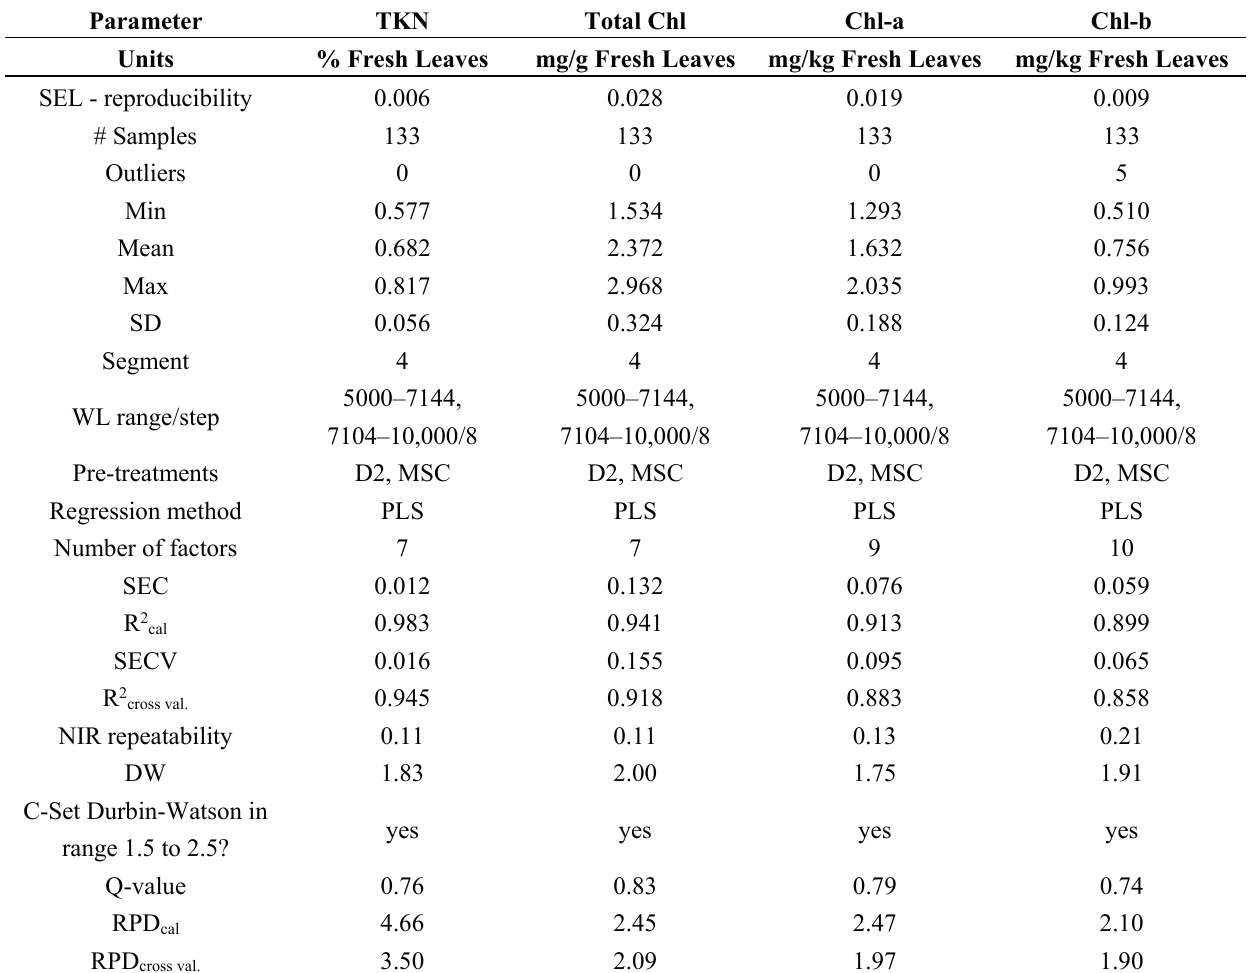
Table 2. Statistics of calibration- and cross-validation